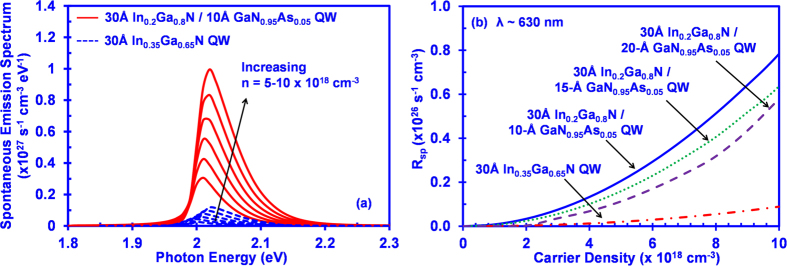
(a) Spontaneous emission spectra as a function of photon energy with carrier density from 5 × 1018 cm−3 to 1 × 1019 cm−3 for conventional 30 Å In0.35Ga0.65N QW and 30 Å In0.2Ga0.8N/10 Å GaN0.95As0.05 QW and (b) Spontaneous emission rate Rsp as a function of carrier density for conventional 30 Å In0.35Ga0.65N QW, 30 Å In0.2Ga0.8N/10 Å GaN0.95As0.05 QW, 30 Å In0.2Ga0.8N/15 Å GaN0.95As0.05 QW, and 30 Å In0.2Ga0.8N/20 Å GaN0.95As0.05 QW at T = 300 K.